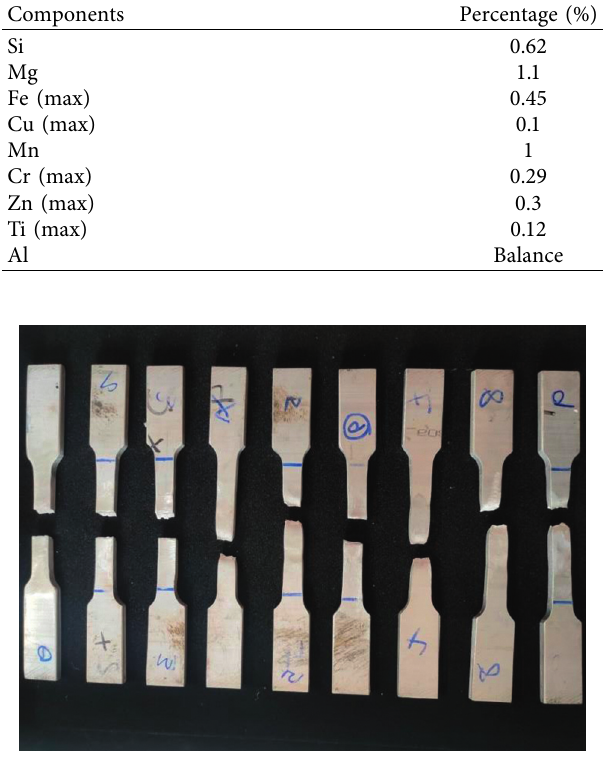
Figure 3: Tensile test specimens as per ASTM E8